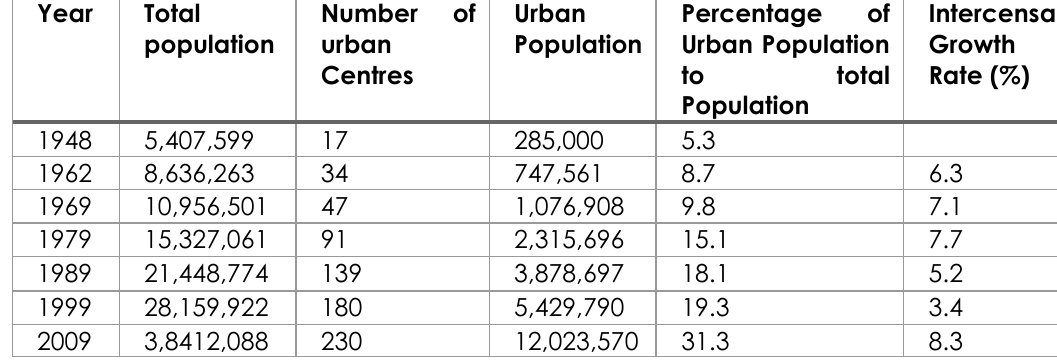
Table 1 . The Trend of Urbanization in Kenya (1948-2009) Year